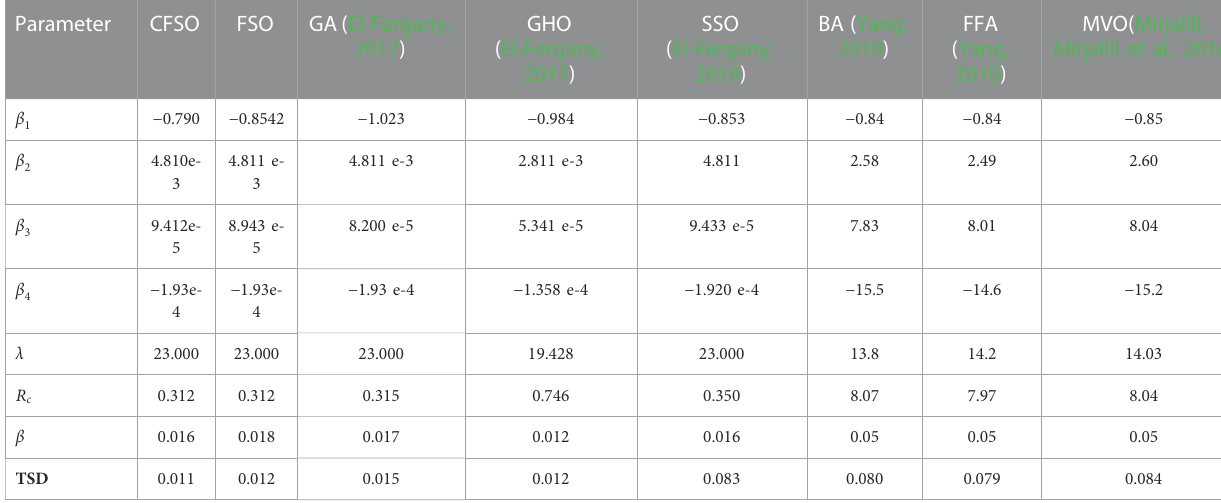
TABLE 5 TSD validation for the BCS PEMFC.